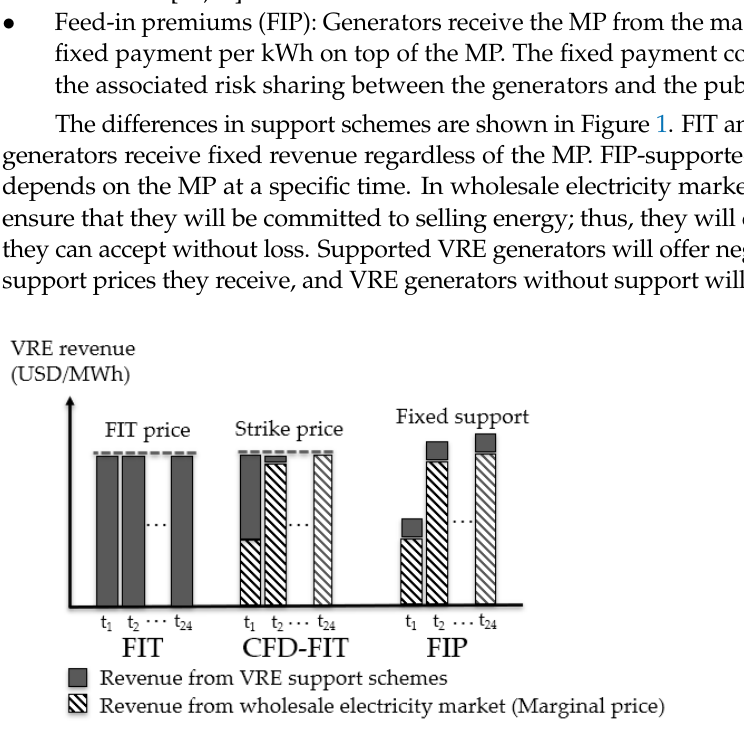
Figure 1. The differences among the support